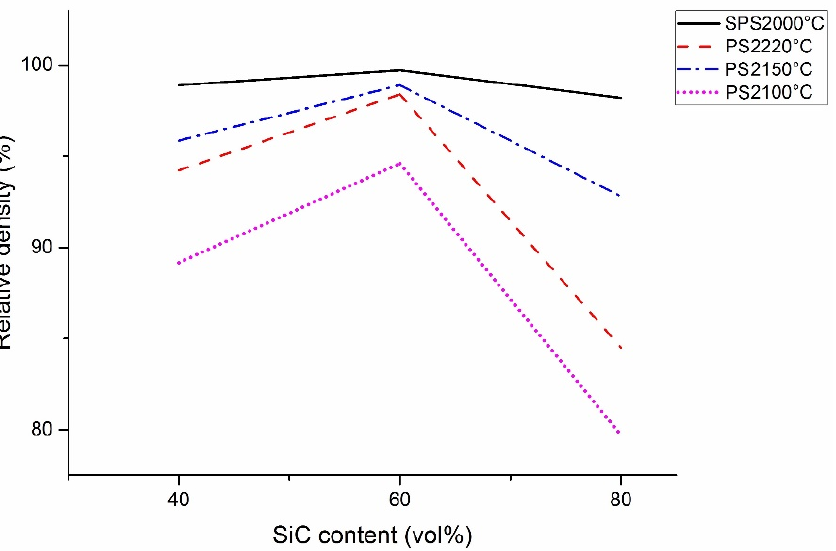
Figure 2. Relative density comparison of sintered SiC-TiB 2 -TiC composites by SPS and PS [47]. For each temperature, the minimum density is observed in the 80SiC samples, while the 60SiC samples reach the maximum value. It can be seen that the highest relative density (99.7%), as well as the smallest difference between the maximum and minimum values (only 1.5%), occurs with SPS. PS samples have a lower relative density and larger differences (14.9%, 6.1%, and 13.9% at 2100 ◦ C, 2150 ◦ C, and 2220 ◦ C, respectively) in comparison with SPS